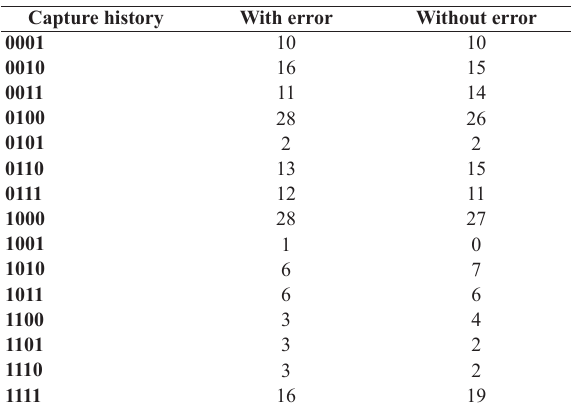
Table 4. Frequency of capture histories of Amolops formosus for four